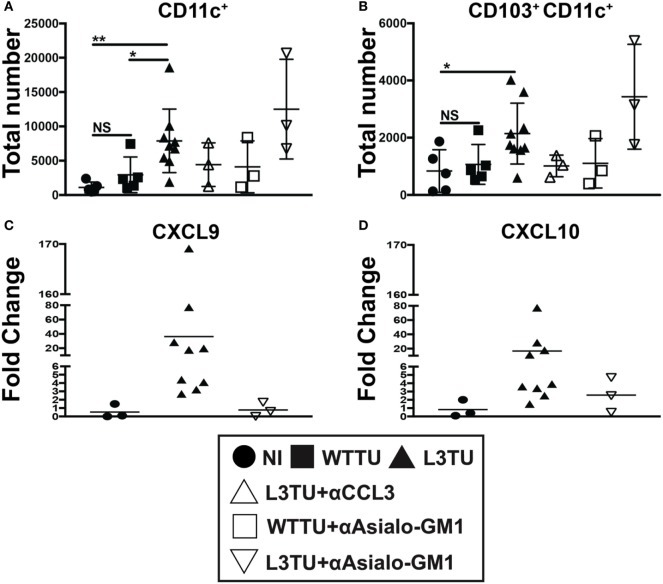
Natural killer (NK) cells, not CD103+ CD11c+ dendritic cells (DCs), drive IFNγ-induced CXCL9 and CXCL10 production in the L3TU tumor-draining lymph node (TDLN). (A,B) Absolute total and CD103+ subset of CD11c+ cell numbers in the TDLN 5-days post-tumor injections were numerated by FACS. N = 3 mice per cohort. non-injected (NI), WTTU, and L3TU injection groups were conducted simultaneously with each depletion experiment and combined into the present graphs. IgG1a antibody was administered to NI, WTTU, and L3TU cohorts as for CCL3 blockade or NK depletion. (C,D) Fold change of CXCL9 and CXCL10 mRNA expression in the L3TU TDLN compared to that of WTTU group. Lymph nodes (LNs) from two to three mice in the NI group were pooled for analysis due to low mRNA content. Not significant (ns), p > 0.05; *p = 0.01–0.05; **p = 0.001–0.01; ***p = 0.0001–0.001; ****p < 0.0001.